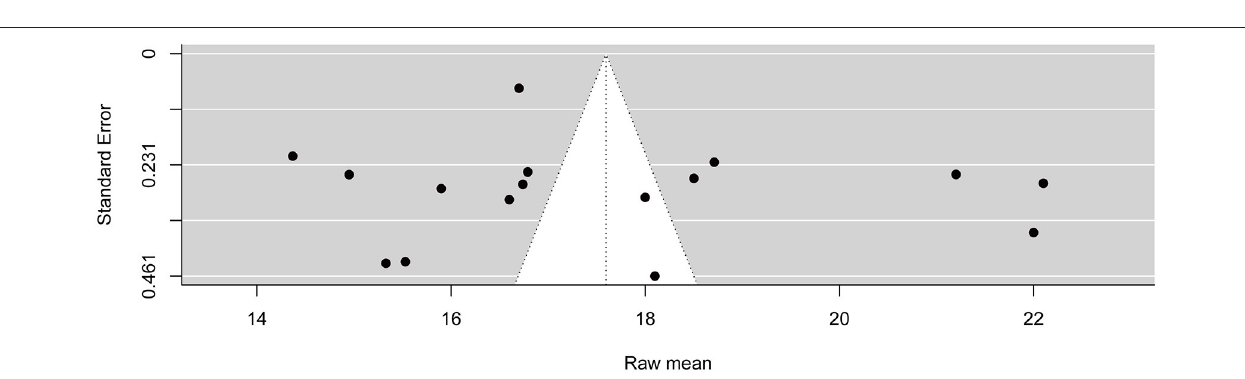
FIGURE 4 | Forest plot of the total mean score of fear, according to publication year.